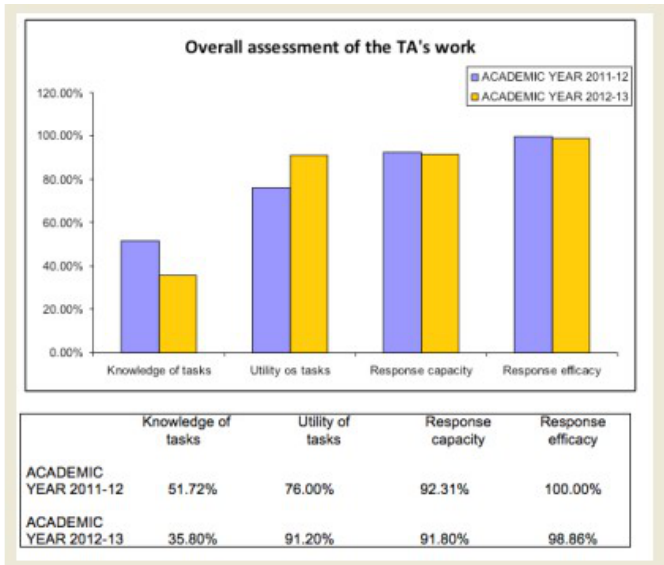
Figure 2. Overall satsfacton with the TAs’